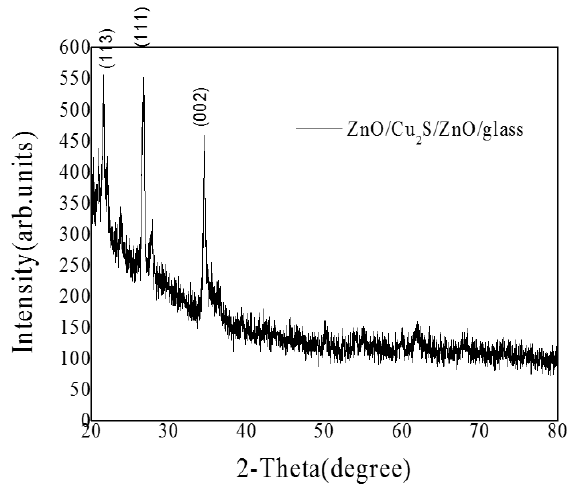
Figure 28. The XRD patterns of ZnO/Cu 2 S/ZnO/glass films.